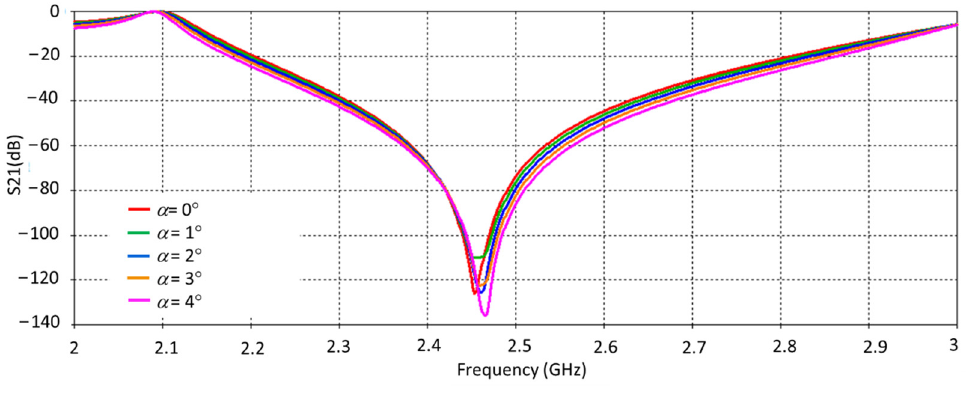
Figure 10. Effect of the mode stirrer axis’s inclination ( α ) from its ideal position.